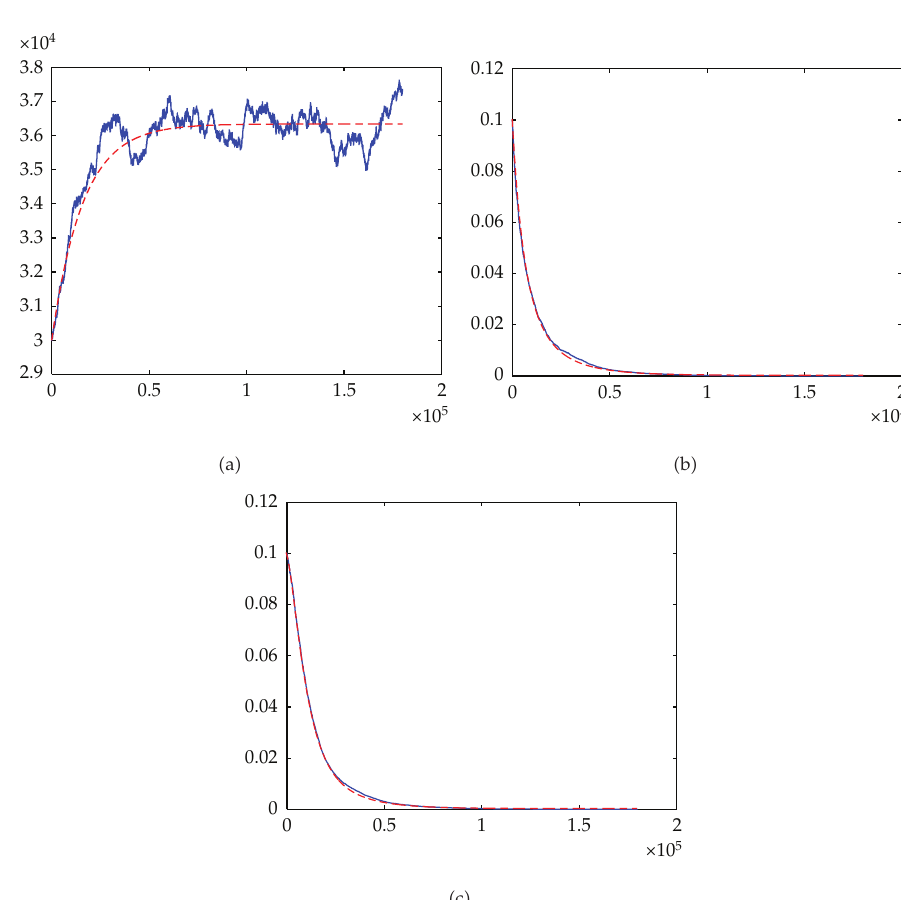
Figure 2: Deterministic and stochastic trajectories around infection-free